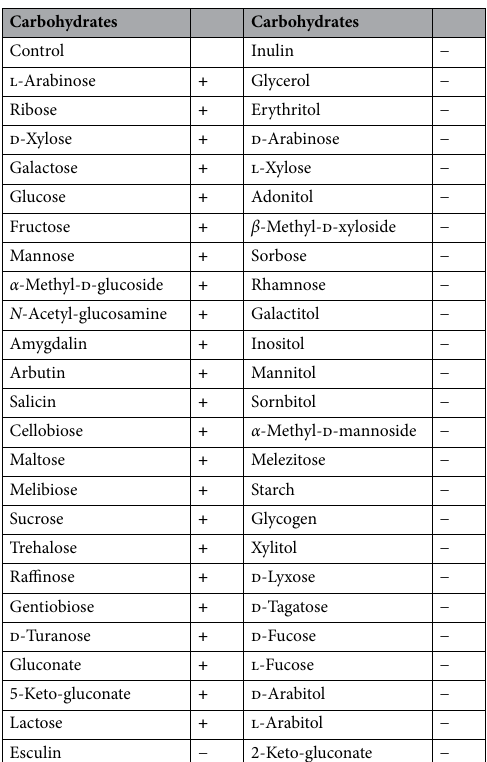
− Table 1. Carbohydrate utilization by Leuconostoc mesenteroides TBE-8. *The ability of TBE-8 to metabolize the corresponding carbohydrates is represented as positive (+) or lack of fermentation (−).